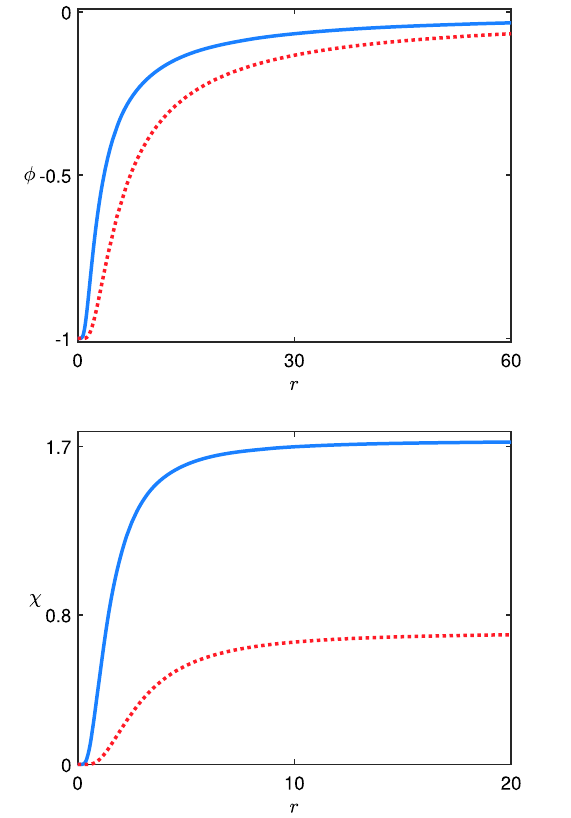
Fig. 4 The solutions φ( r ) (top) and χ( r ) (bottom) associated to the model in Sect. 3.2 for σ = 5, with k = 1 (solid, blue line) and 2 (dotted, red line)